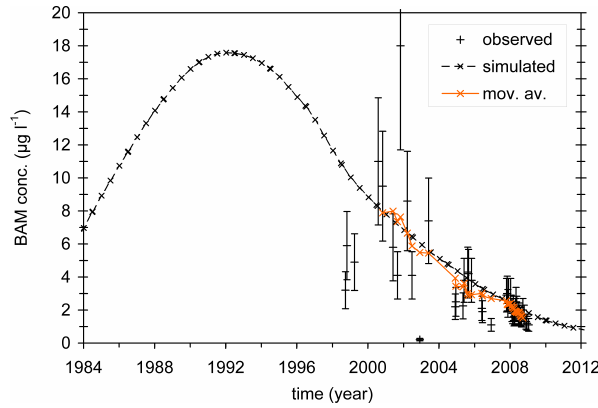
Fig. 4. Simulated and observed BAM concentrations at observation well #7705 located at the nursery field (see Fig. 2). The analysis error was ± 35% and is indicated by error bars. The moving average is the average of the closest four observations, before and after each observation. The observed peak value in 2001 was characterized as an outlier according to Dixon’s